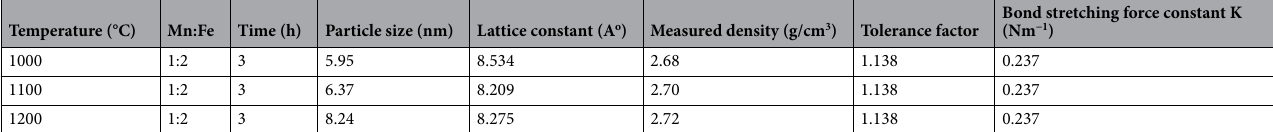
Table 1. The measured values of the particle size, lattice constant, density, tolerance factor and bond stretching of the samples sintered at 1200 °C.